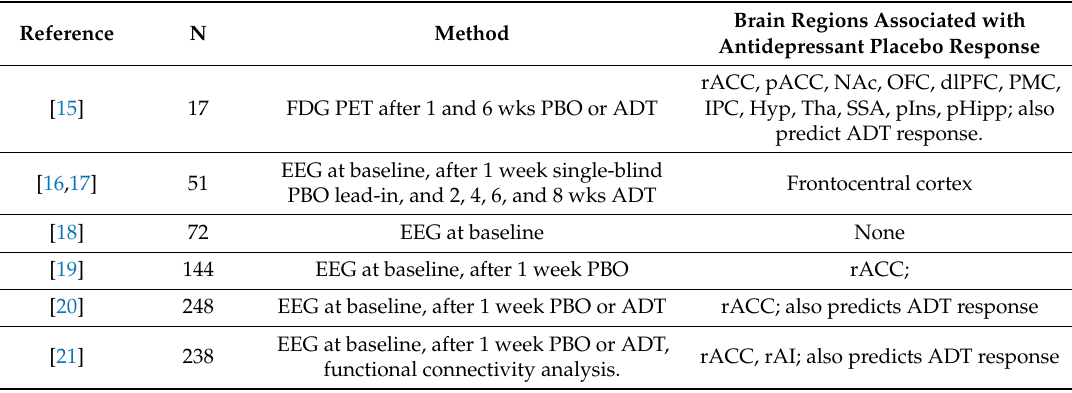
Table 1. Imaging data of the antidepressant placebo response, captured in clinical trials primarily focused on antidepressant e ffi cacy or predicting antidepressant